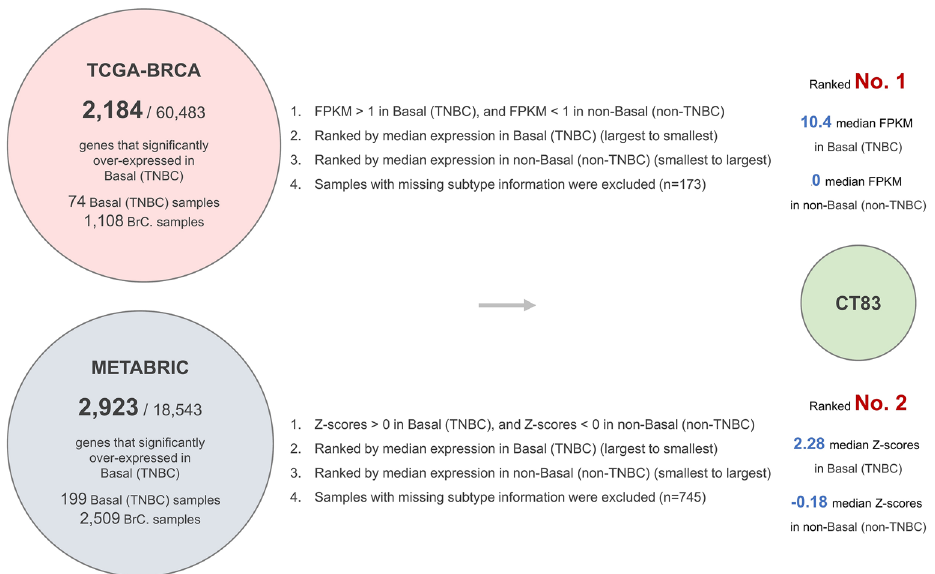
Figure 1. Screening strategies and basic annotations of CT83 . Screening strategies for genes that significantly overexpressed in TNBC but not in non-TNBC subtypes. ( B ) The location of CT83 on chromosome X. ( C ) The schematic diagram of the only transcript of CT83